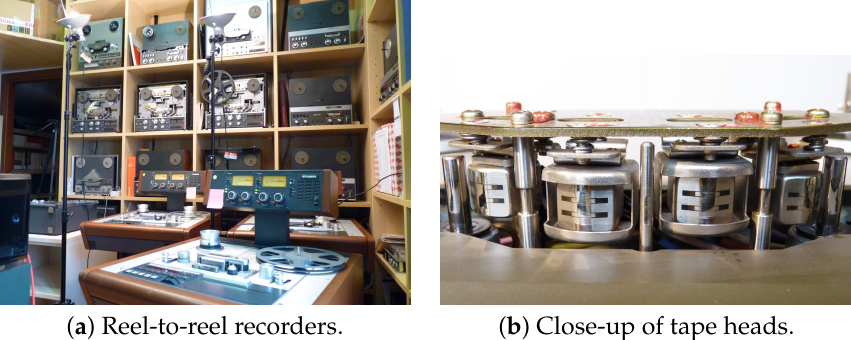
Figure 1. Audio equipment ( left ) and close-up of tape heads ( right ).